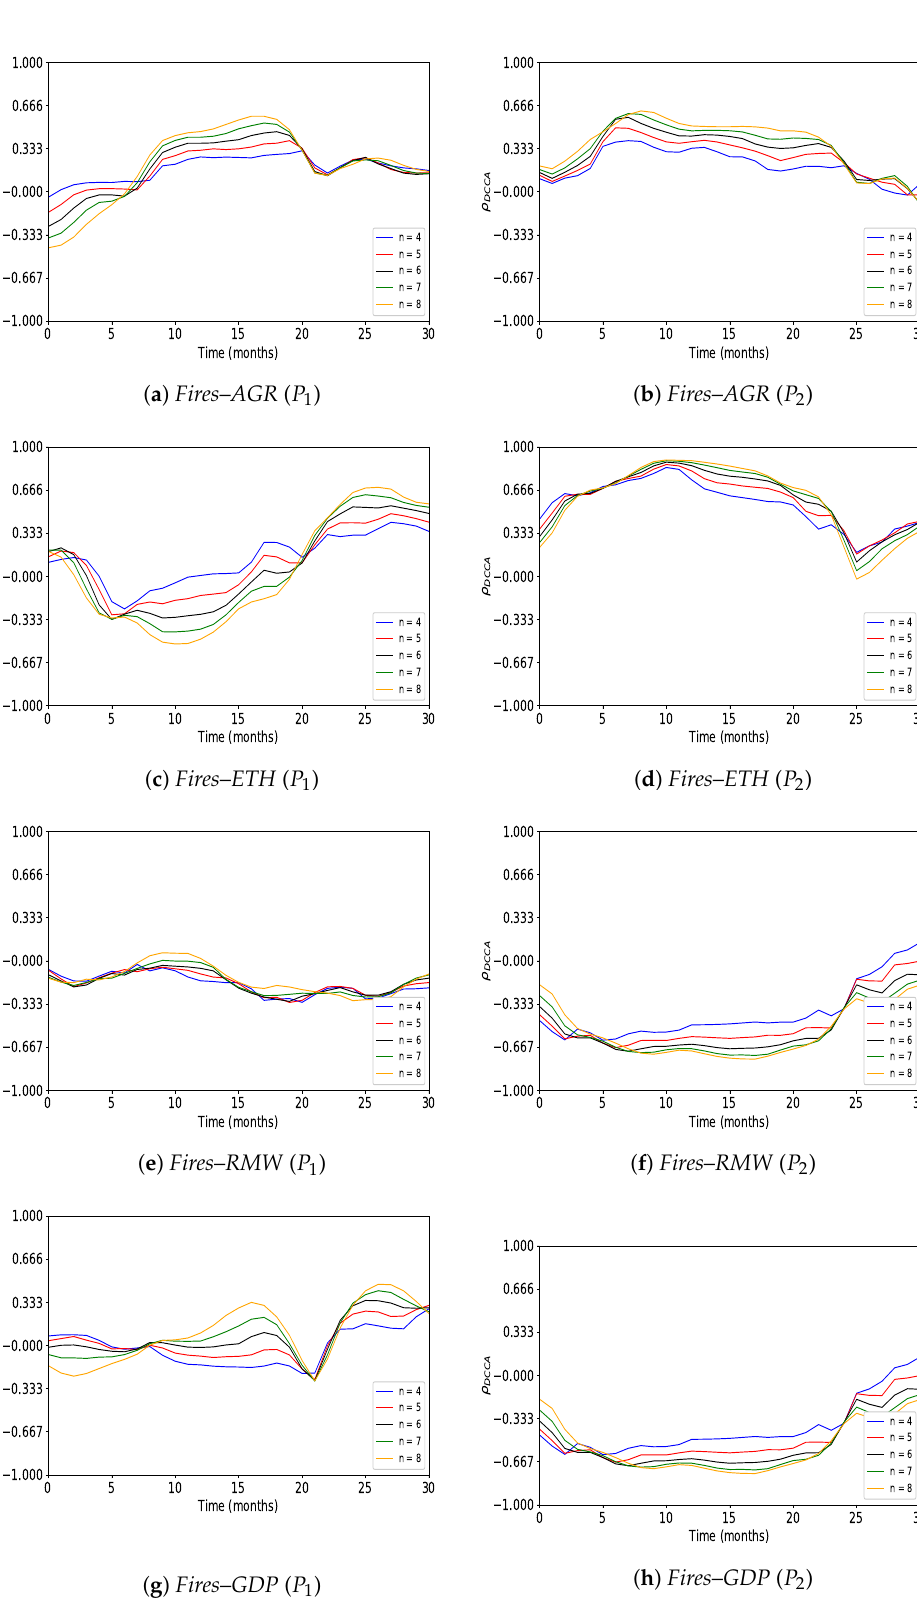
Figure A1. The ρ DCCA comparing TS of P 1 vs. P 2 for